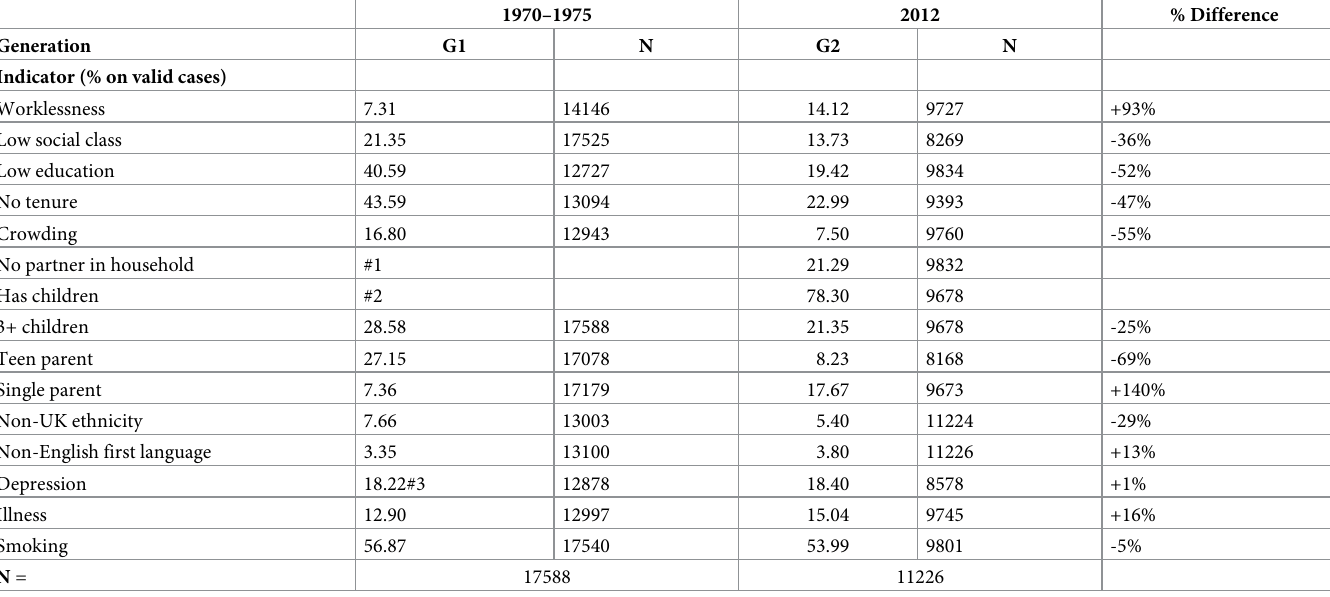
Table 1. Descriptives: Indicators of socio-economic risk by generation (G1, G2) and year of data